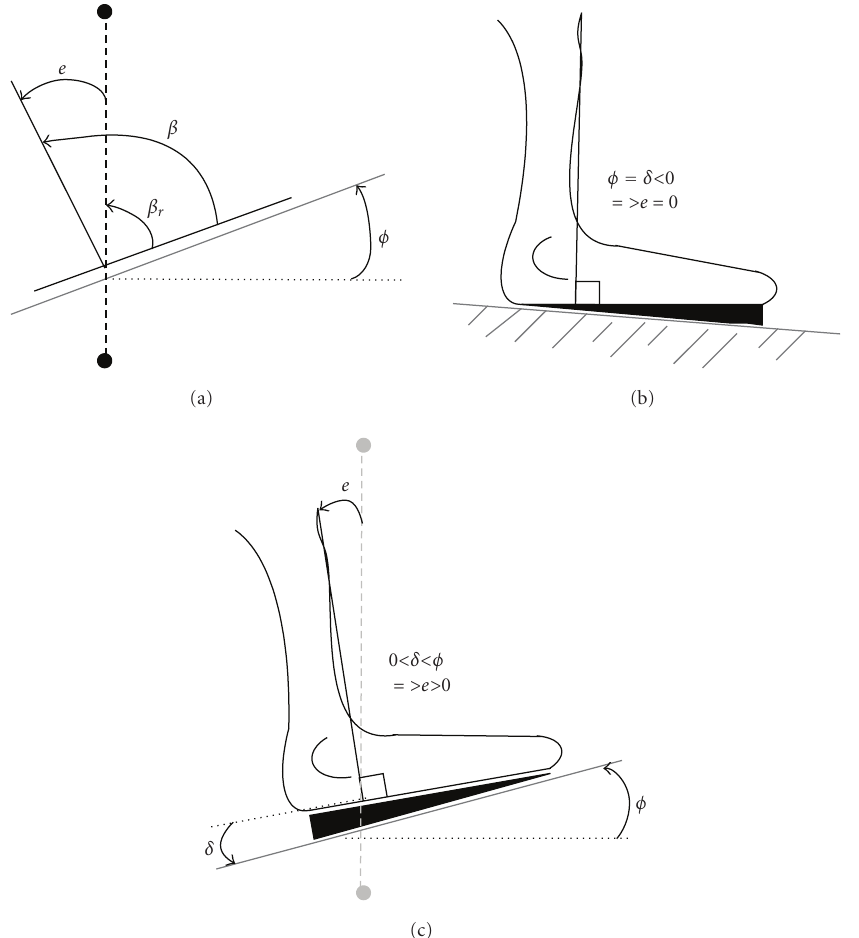
Figure 3: (a) Reference ankle angle β r and actual angle β of an unloaded AFO give a control error e in inclinations. Below: Ankle position of a biological foot during mid-stance while using compensating keels with resulting control error e . (b) The keel angle δ is chosen so that e = 0 and (c) is the error shown as the angle between the actual orthosis and the vertical “desired” direction (dotted).